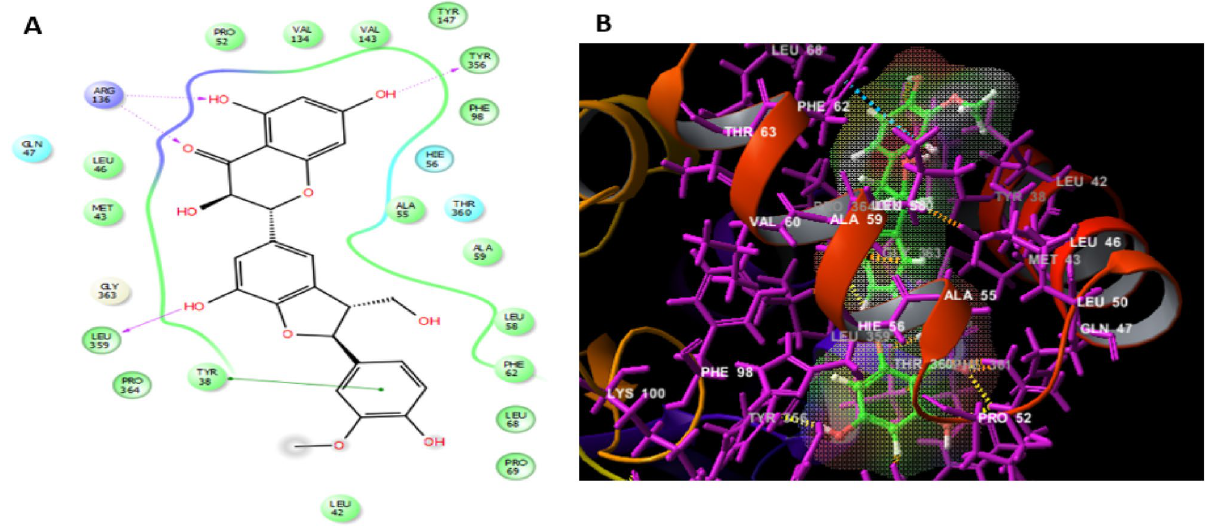
Figure 5. The docked pose of silychristin B interacting with the amino acid residues of hDHODH active site in 2D ( A ) and 3D ( B ) sketches.